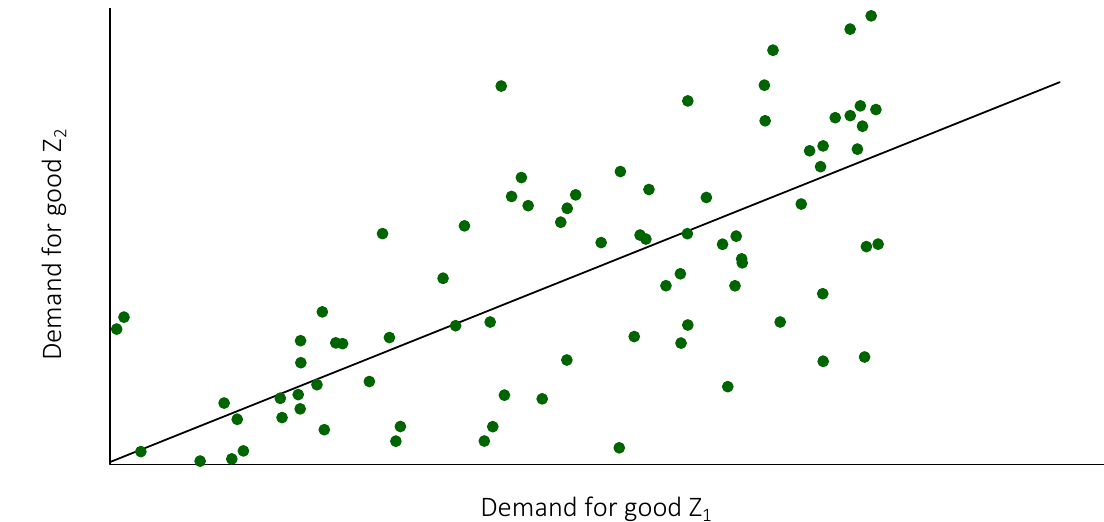
Demand for good Z Figure 1b. Schematic illustrations of demand for two public goods, if they are complements.